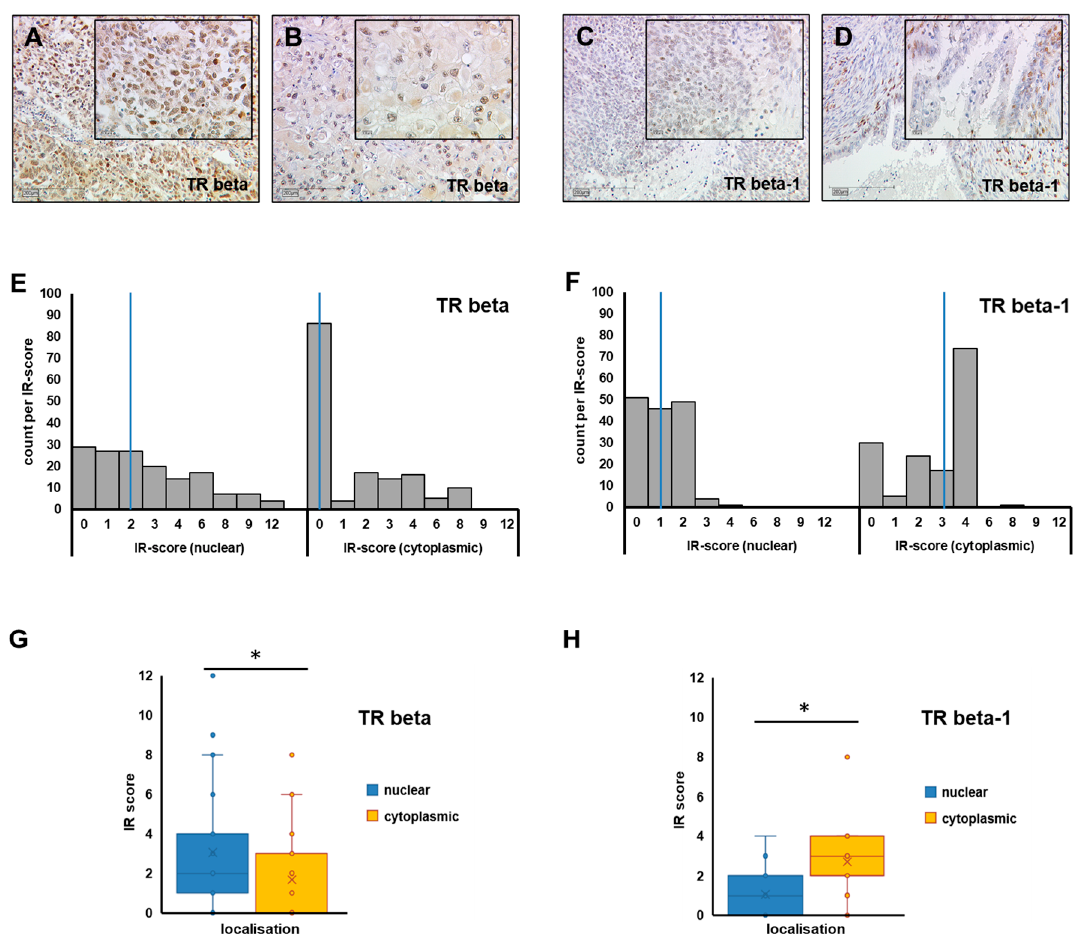
Figure 1. TR beta/TR beta-1 in ovarian cancer tissue. Representative images of TR beta ( A , B ) and TR beta-1 ( C , D ) as stained by immunohistochemistry in different OC histologic subtypes (A: high-grade serous, B: clear cell, C: endometroid, D: mucinous) are shown ( A – D ). Scale bars in images ( A – D ) represent 200 µm, and scale bars in insets are 100 µm. Nuclear and cytoplasmic staining was assessed independently and quantified by applying the IR-score. The number of cases per IR-score are plotted as histograms ( E , F ), and the median IR-score for each analysis (E: TR beta, F: TR beta-1) is highlighted by a blue vertical line, respectively. To compare median IR-scores of nuclear (blue) vs. cytoplasmic (yellow) staining, box plots ( G : TR beta, H : TR beta-1) were plotted and differences were tested for statistical significance. Significant differences ( p < 0.001), as determined by relevant Mann–Whitney U tests in G and H, are indicated by stars (*).